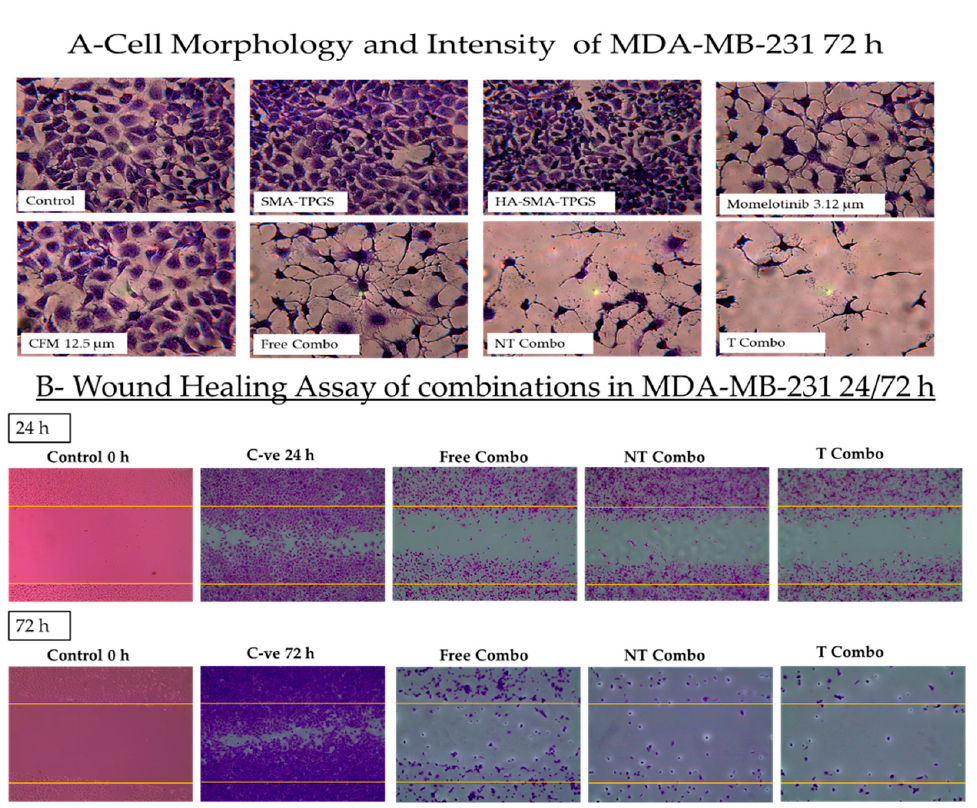
Figure 7. The impact of the combination on the cell morphology and wound healing. The morphological changes ( A ) and the ability of the cells to proliferate and migrate to fill the induced gap in MDA-MB-231 ( B ) is illustrated by crystal violet stain. For the wound healing, the plates were treated as follows; negative control at 0, 24, 72 h, free combo, NT combo, and T combo at 24 and 72 h Note: T combo (CD44-T-PNPs+MMB),NT combo (NT-PNPs+MMB) and free combo (CFM-4.16 + MMB) where MMB means momelotinib. Images were taken at 10× magnification power.